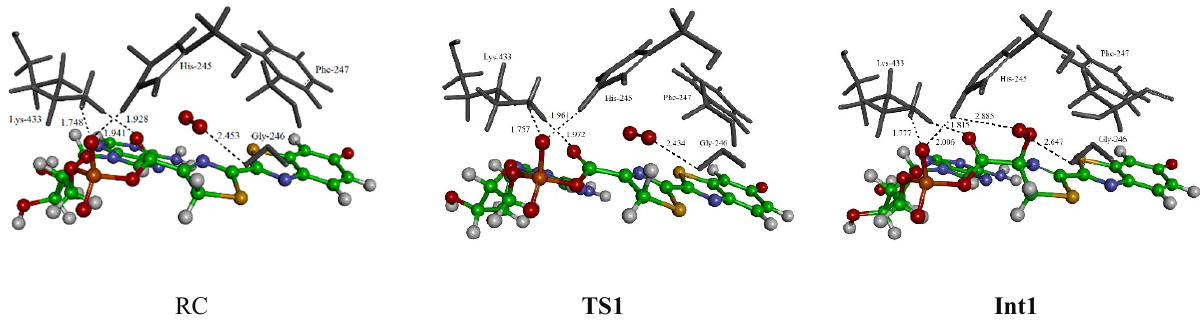
Figure 4. The interactions between RC, TS1, Int1 and residues in an active site by ONIOM method (UM06-2X/MM). (The protein environment is not shown).